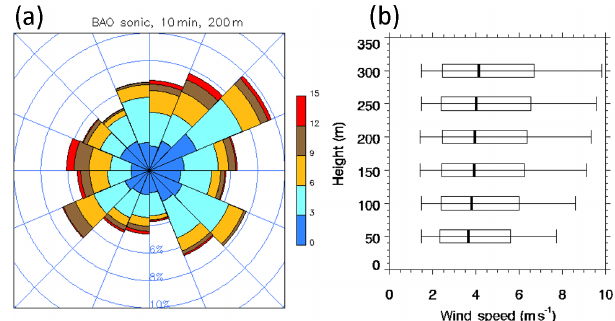
Figure 2. (a) Wind rose from 10min averaged sonic anemome- ter data at the 200m level on the BAO tower and (b) box and whisker plot of 10min averaged wind speeds from the tower sonic anemometers. The box and whiskers indicate the 10th, 25th, 50th, 75th and 90th percentiles. Both plots use data spanning the period from 6 March through 16 April